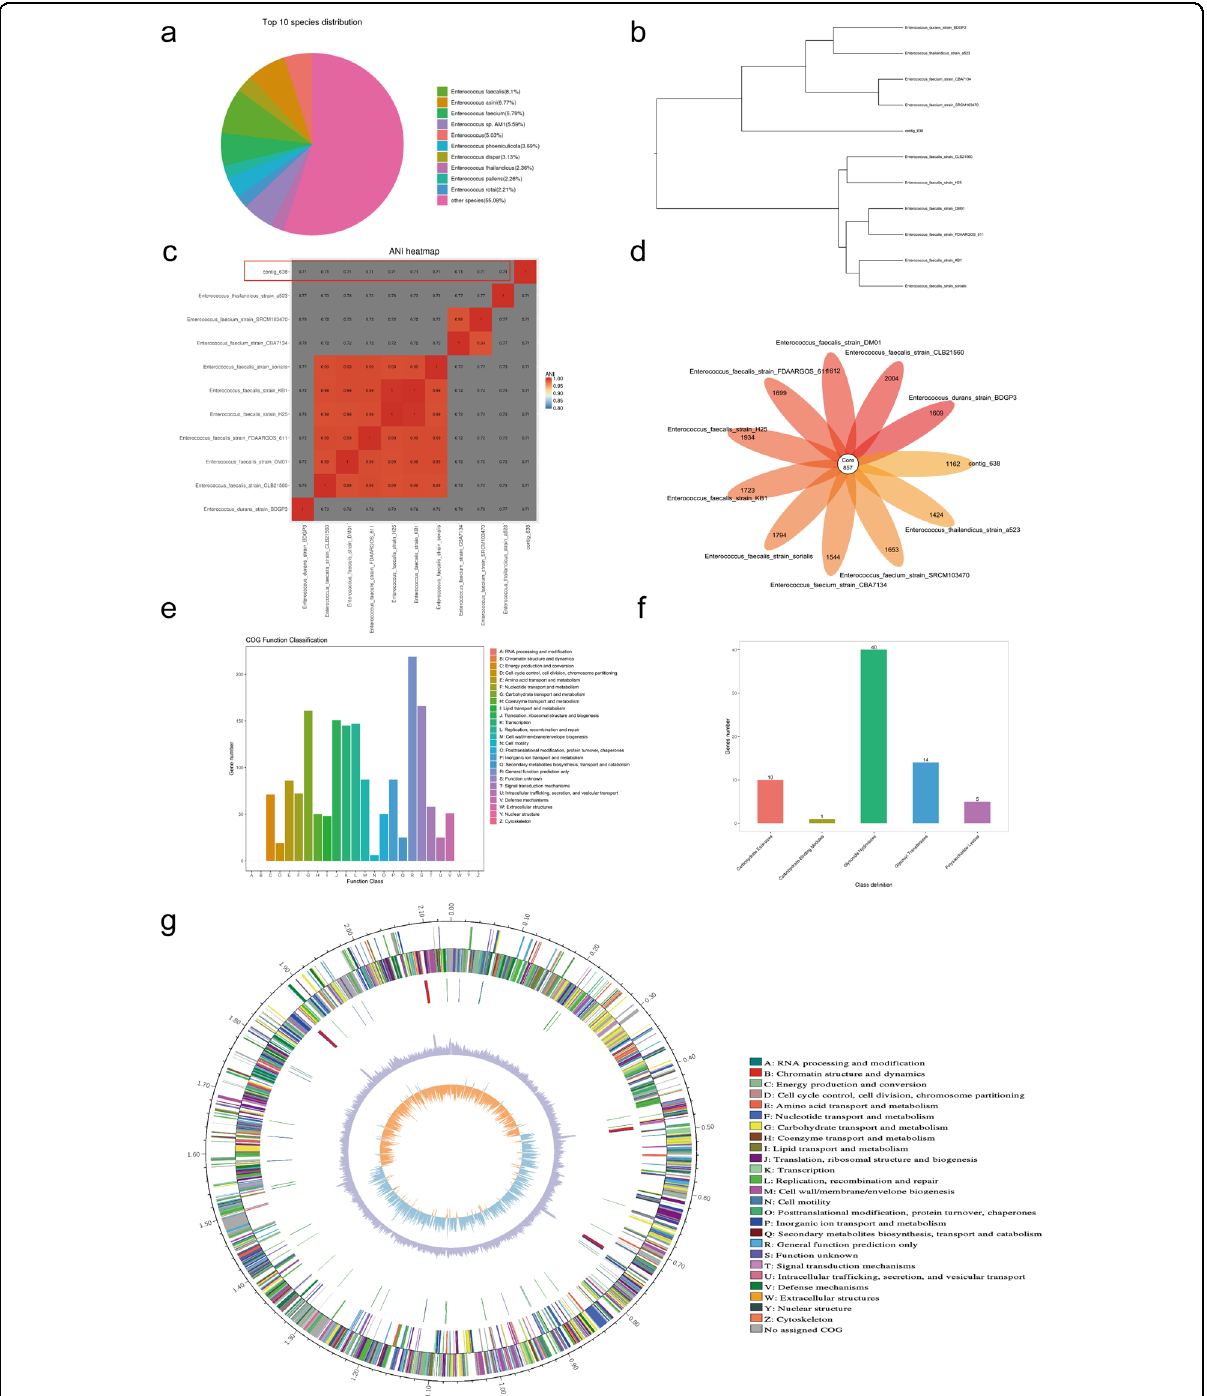
Fig. 5 Genome aspects of the new species of Enterococcus tongjius . a Non-redundant database annotations of contig_638. b Phylogenetic tree of the high contig_638 through whole genomes. c The ANI analyses showed that contig_638 was a total new species since the ANI score was only 0.71, much lower than 0.9. The red frame displayed the scores of contig_638. d A fl ower-plot schematic representation illustrates the number of predicted core (857) genes and distinctive genes . e Function analyses of the CDSs of the Enterococcus tongjius . f Carbohydrate-active enzymes analysis of the Enterococcus tongjius . g Circos diagram of the whole genome of the Enterococcus tongjius (From the inner to the outer are GC skew, GC content, non-coding RNA (rRNA red, tRNA blue, sRNA green), lagging strand COG annotation, leading strand COG